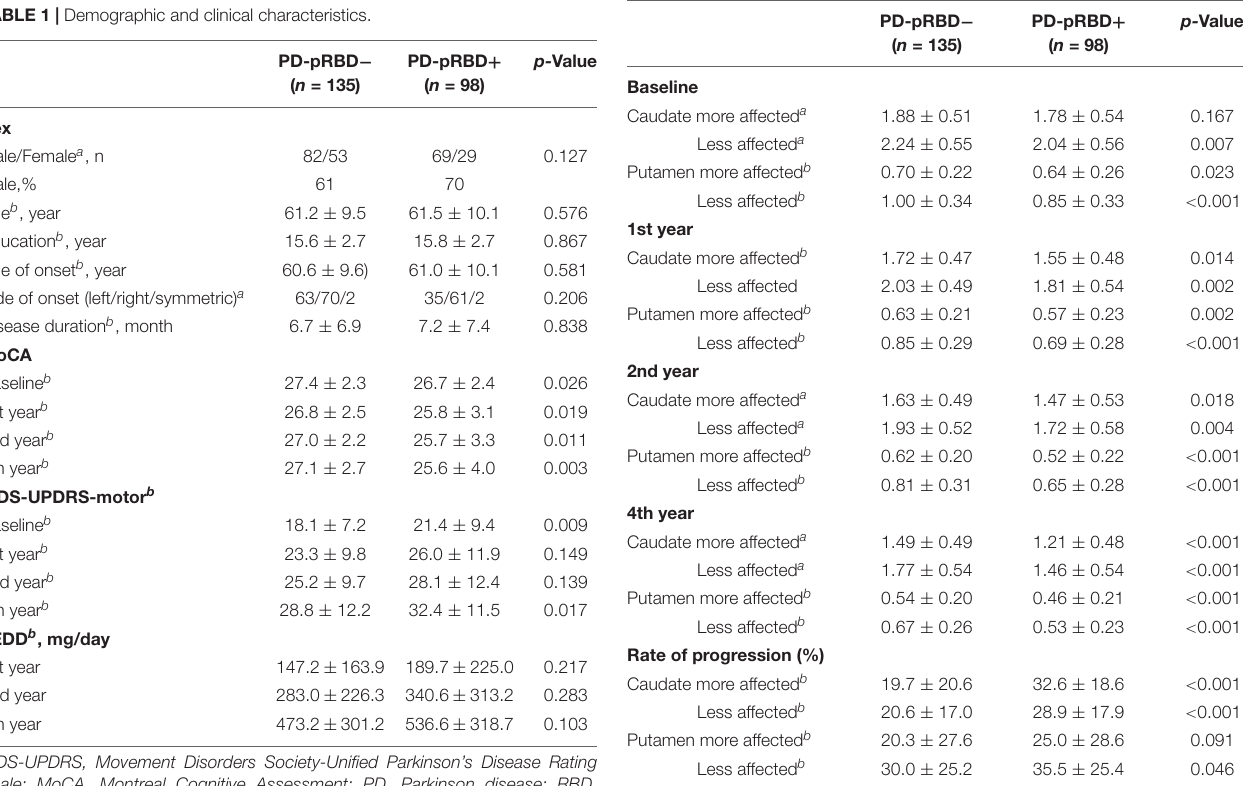
TABLE 2 | DAT binding levels and rates of decline in striatal